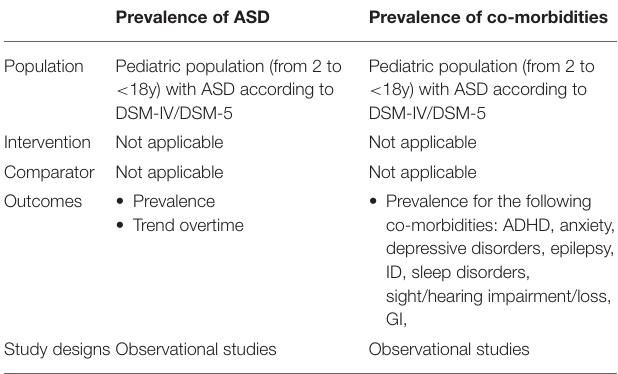
TABLE 1 | PICOS criteria. Prevalence of ASD Prevalence of co-morbidities